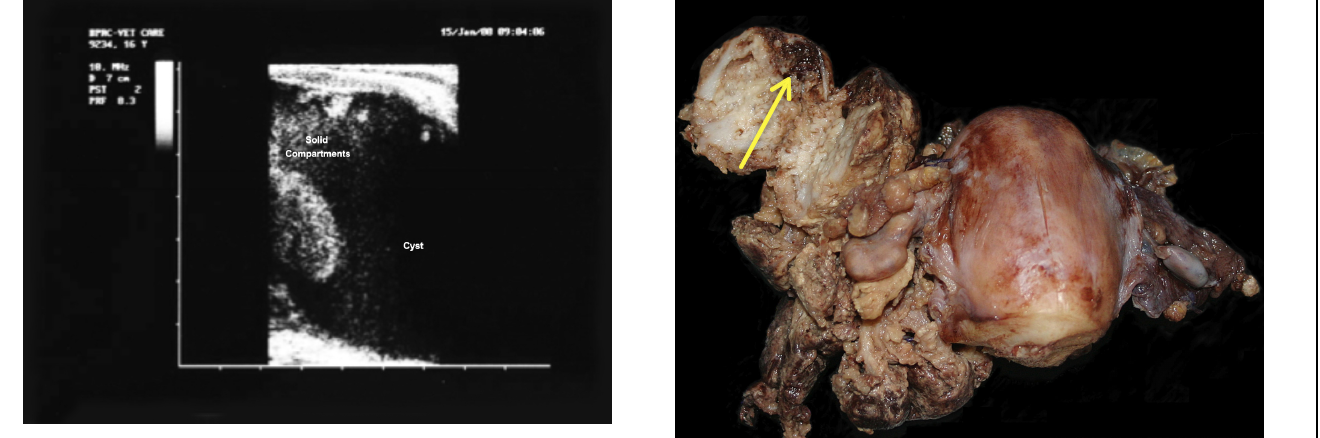
Figure 1. Ultrasound image of endometrial lesions of a 16-year-old rhesus macaque no. 9234 from the BPRC breeding colony. Image was taken with a flat probe, and it shows a cystic lesion with solid compartments.